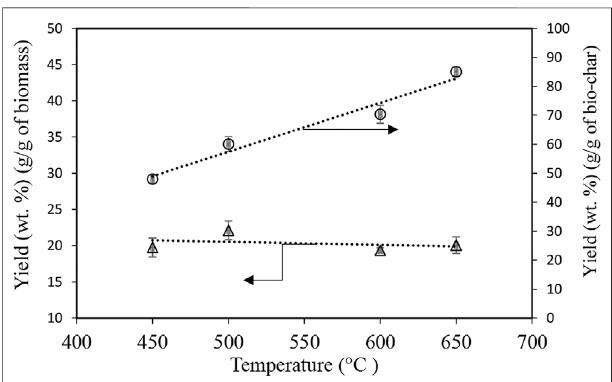
FIGURE 3 | Yield of activated carbon produced using bio-char samples generated at 450, 500, 600, and 650 ° C with the same activation time of 3 h with CO 2 fl owrate of 0.5 L/min, normalized with respect to the mass of bio- charandbiomassat900 ° C,Trendlinesareaddedforabetterillustration.